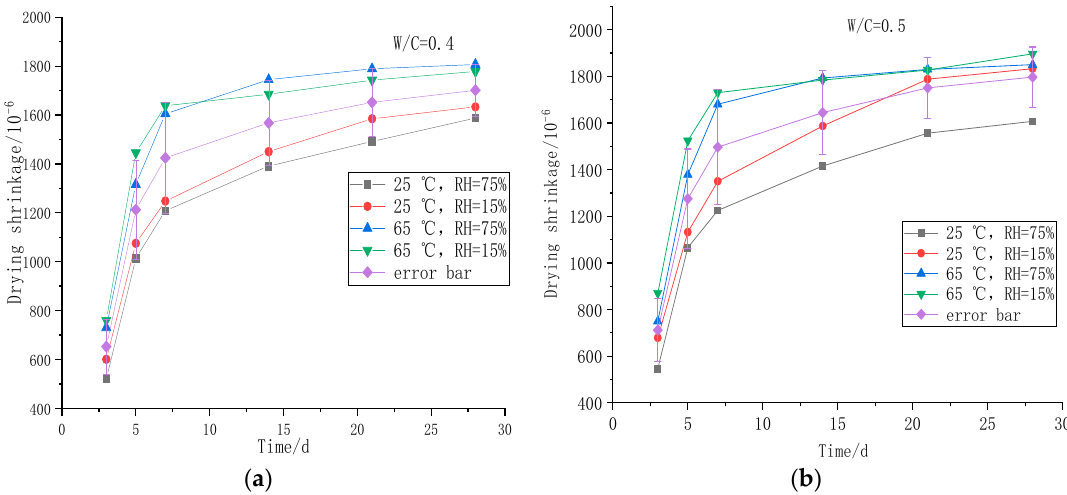
Figure 8. Drying shrinkage of foamed concrete under different curing humidity: ( a ) 0.4 water–cement ratio dry shrinkage of foamed concrete; ( b ) 0.5 water–cement ratio dry shrinkage of foamed concrete.